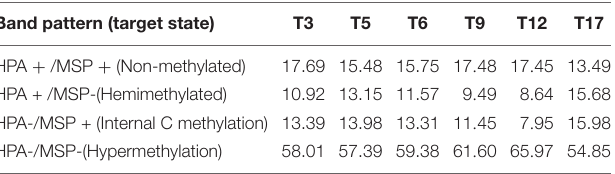
TABLE 3 | DNA methylation status of target sequences (percentages) from each time point.